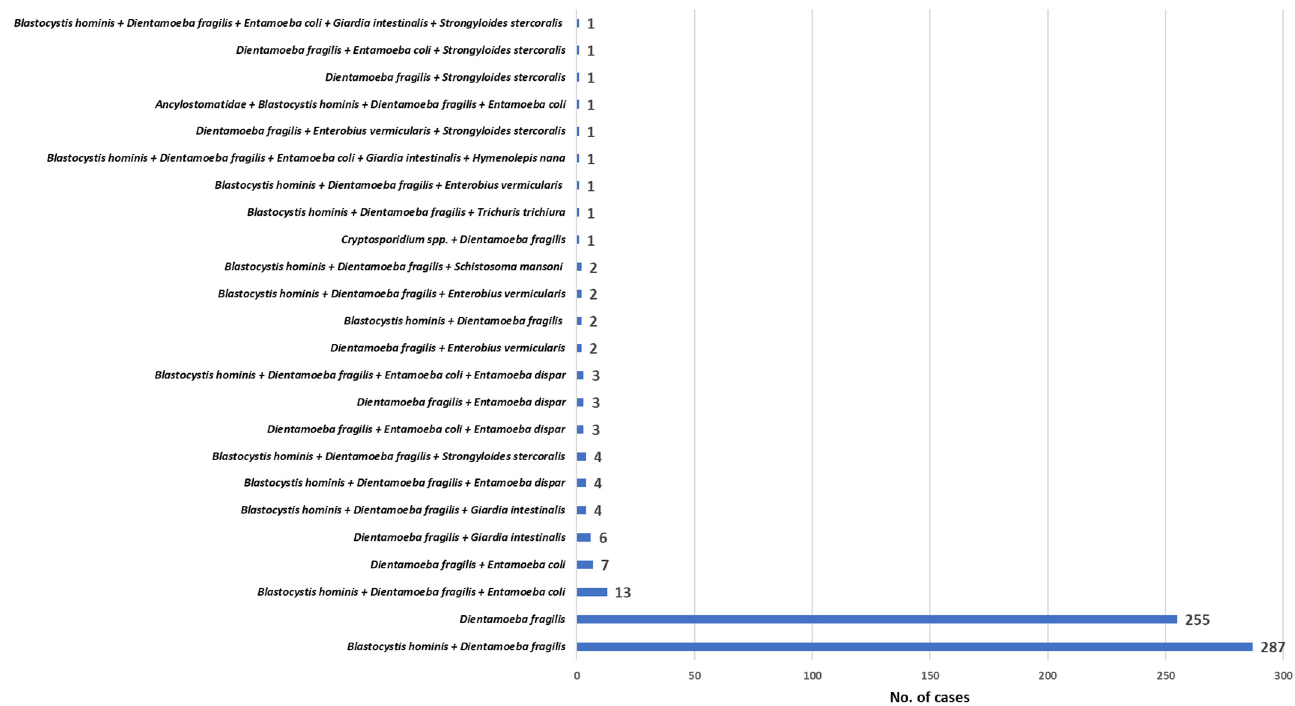
Figure 1. Different combinations of the 606 cases of dientamoebiasis. The cases of dientamoebiasis in comparison with total intestinal parasitoses per each year are reported in Figure 2.